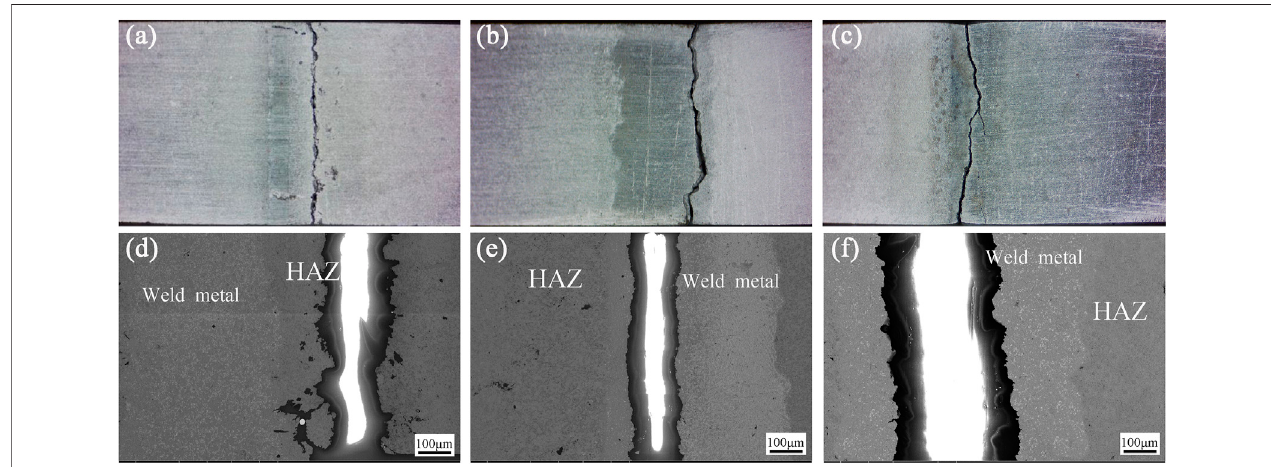
FIGURE 13 | Fracture path of SiCp/6061Al laser welded joint: (A,D) laser welding, (B,E) laser welding Ti interlayer, (C,F) Ultrasonic-assisted laser welding with Ti interlayer.